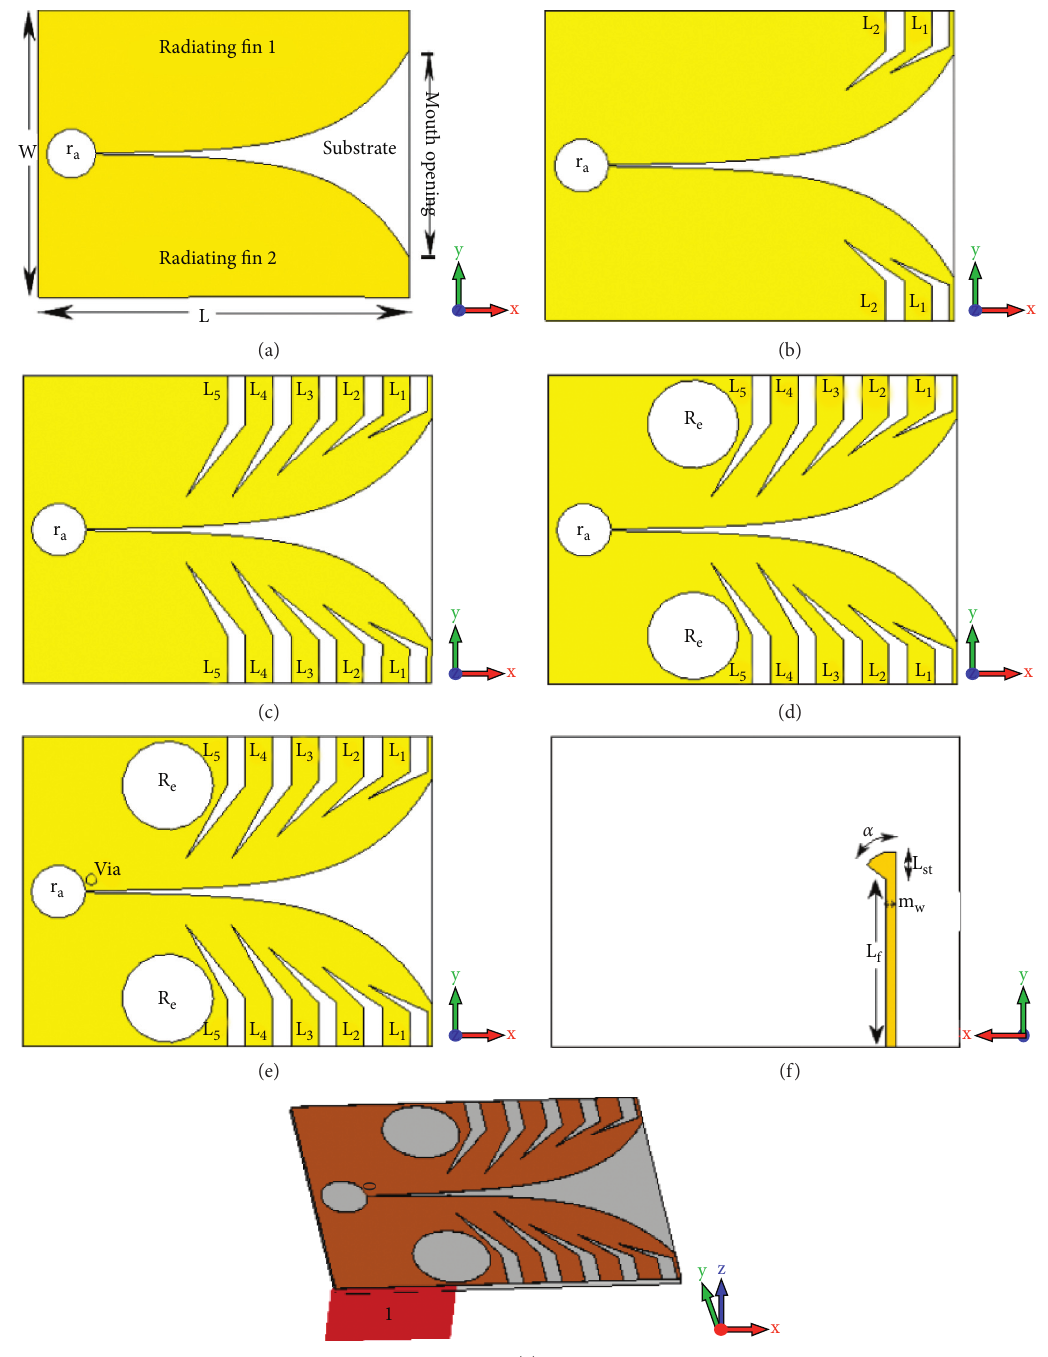
Figure 1: Evolution process of the proposed Vivaldi antenna: (a) Step 1 (front view); (b) Step 2 (front view); (c) Step 3 (front view); (d) Step 4 (front view); (e) Step 5 (front view) (proposed); (f) back view; (g) 3D view of the proposed